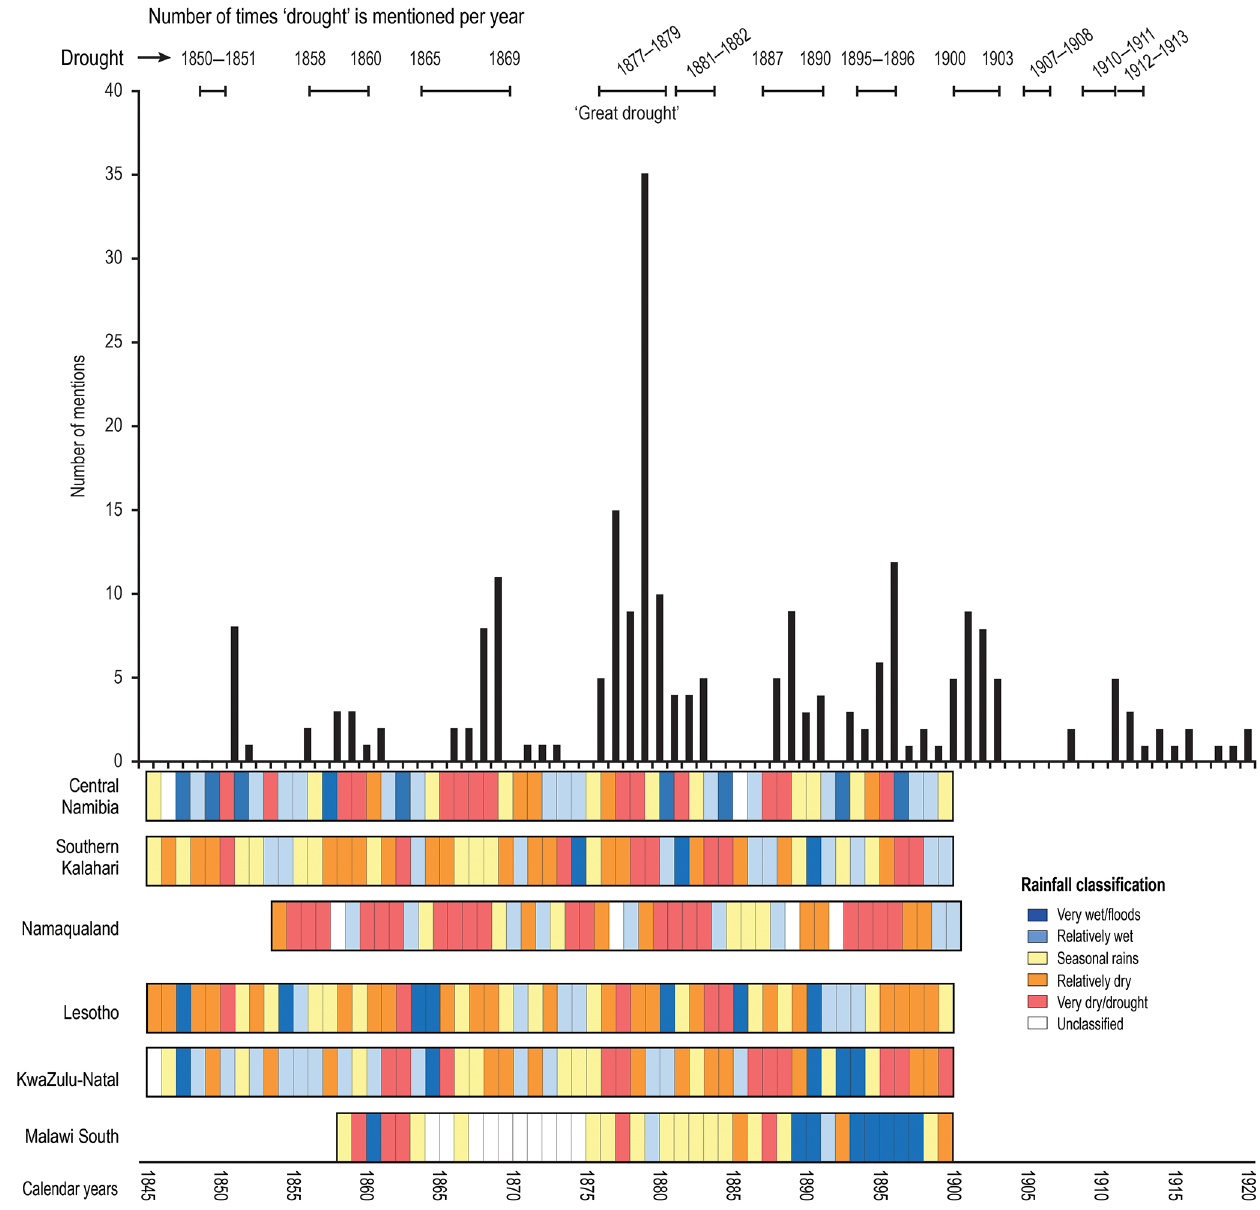
Figure 2. Annual 19th-century rainfall reconstruction for southern African subregions (see also Fig. 1). The bar graph indicates the number of times drought is mentioned in central Namibian documentary sources each year (please note that these results are at least in part influenced by documentary source types and quantity). Information sources: southern Kalahari – Nash and Endfield (2008); Namaqualand – Kelso